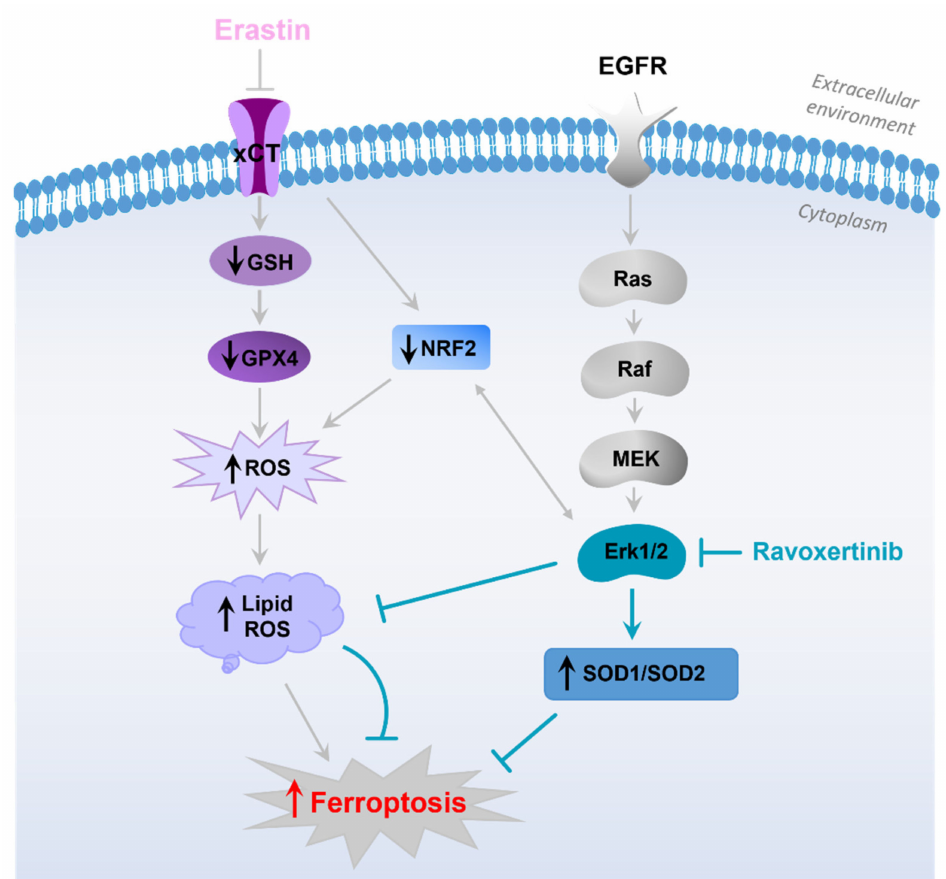
Figure 8. Hypothetical sequence of events leading to development of ferroptosis in HNSCC cells in response to erastin treatment. The schematic diagram illustrates that erastin inhibits xCT, resulting in downregulation of GSH, GPX4, and Nrf2 [58]. Decrease in the detoxifying molecules caused by erastin leads to enhanced ROS production, lipid peroxidation, and ferroptosis development [19,57]. EGFR pathway and its downstream Erk1/2 activation plays an important role in HNSCC patho- physiology. Erk1/2, in cooperation with Nrf2 [24], is involved in the modulation of ROS formation and expression of ROS scavengers SOD1 and SOD2. Inhibition of Erk1/2 signaling via specific Erk-inhibitor, ravoxertinib, affects the ratio between ROS levels and ROS scavengers’ expression, resulting in ferroptosis